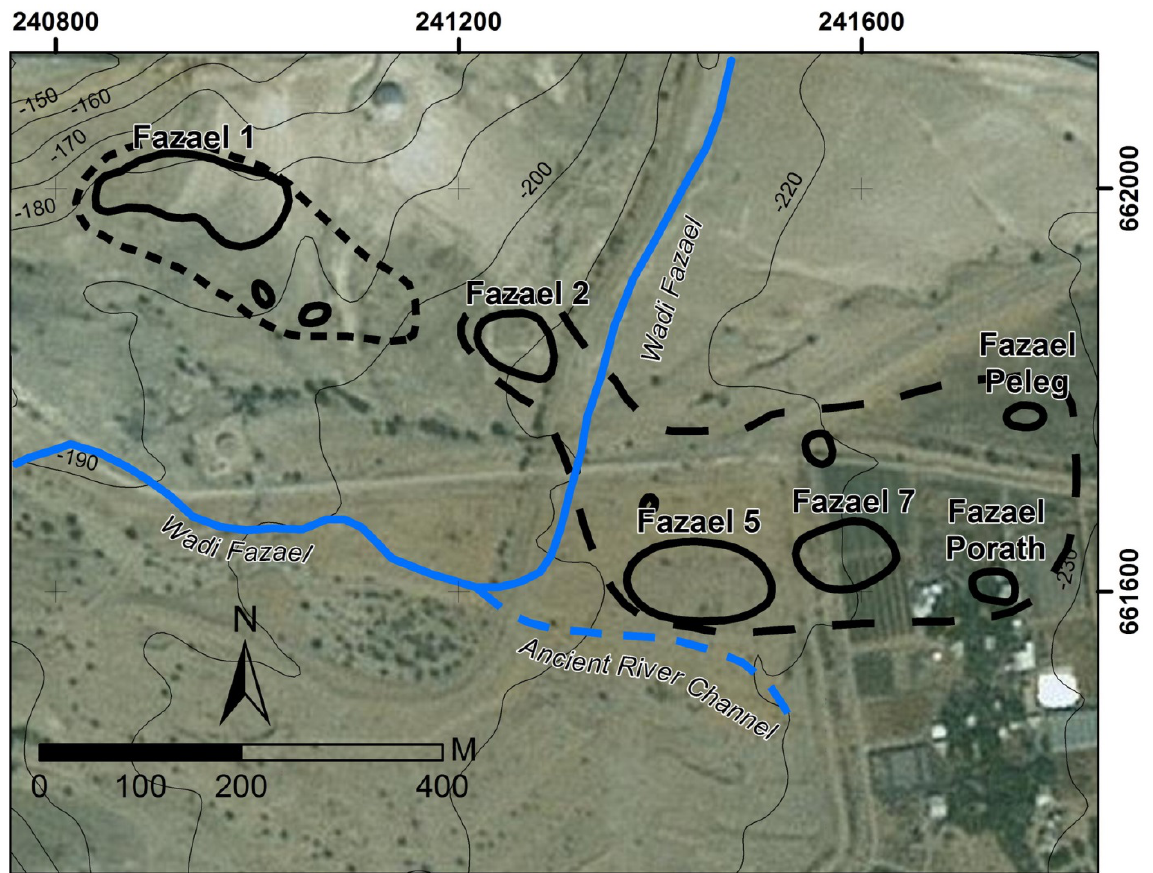
Figure 2. Late Chalcolithic sites identified in the Fazael Valley and the presumed area of the ancient settlement marked within the dashed lines. (Background by ESRI sources: ESRI, DigitalGlobe, GeoEye, Earthstar Geographics, CNES/Airbus DS, USDA, USGS, AEX, Getmapping, Aerogrid, IGN, IGP, Swisstopo, and the GIS User